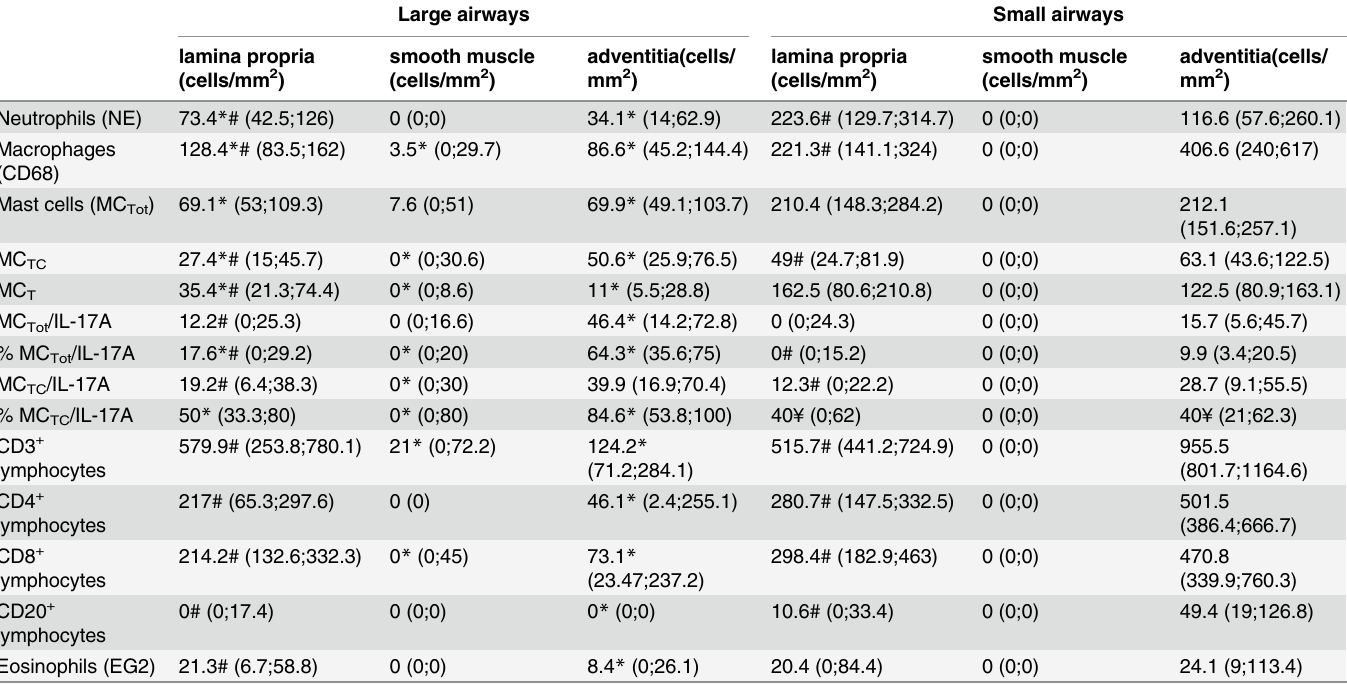
Table 3. Cellular distribution of inflammatory cells in smokers. Large airways Small